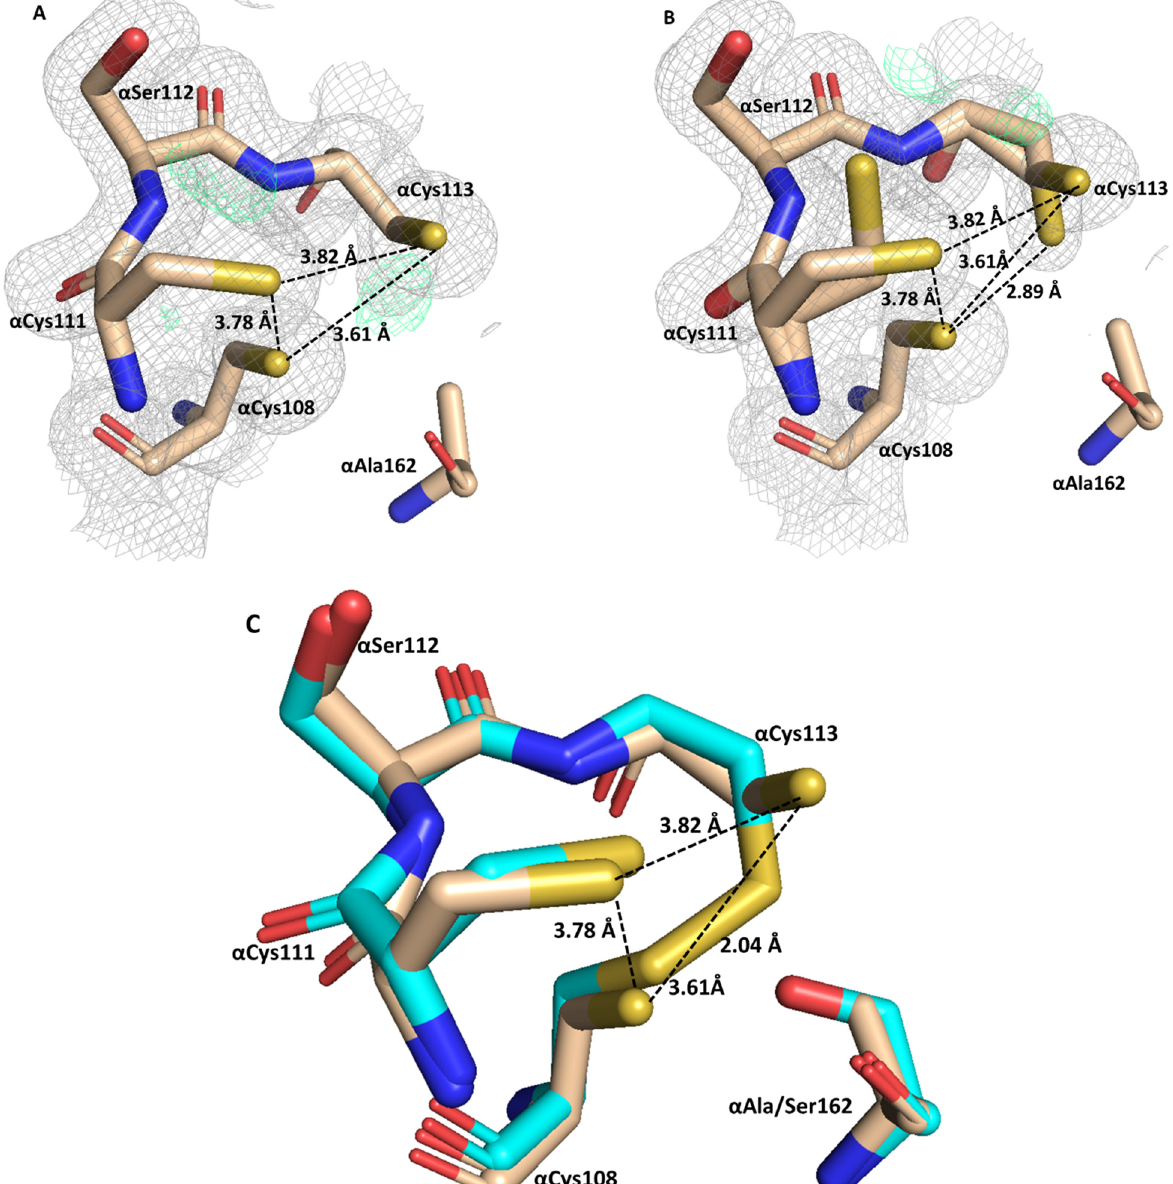
Figure 5. X-ray crystal structure of α Ser A at 1.8 Å resolution. ( A ) Simulated annealing omit map (2Fo–Fc) shown in gray mesh at the 1.0 σ level, contoured at 2.0 σ . Additional electron density (Fo–Fc) omit map shown as green mesh at 3.0 σ level indicating alternate α Cys111 and α Cys113 conformations; (PDB ID: 7SJZ) ( B ) simulated annealing omit map (2Fo–Fc) shown in gray mesh at the 1.0 σ level, contoured at 2.0 σ of α Ser A active site fit with both alternate conformations in a 50:50 ratio (PDB ID: 7SJZ); ( C ) superposition of active site of α Ser A (wheat tint) and Apo- Pt NHase(cyan) (PDB: 1GUQ). All bond distances shown in angstroms.